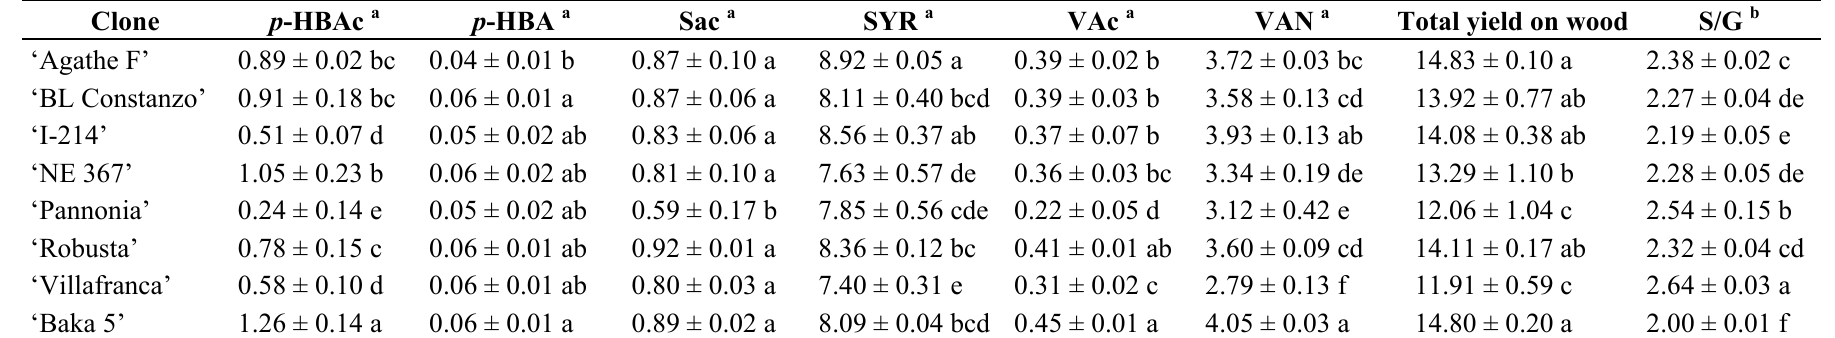
Table 4. The results of nitrobenzene oxidation (%) for the examined clones of Populus grown on the Sliepkovce experimental site. Data represent means ± SD.